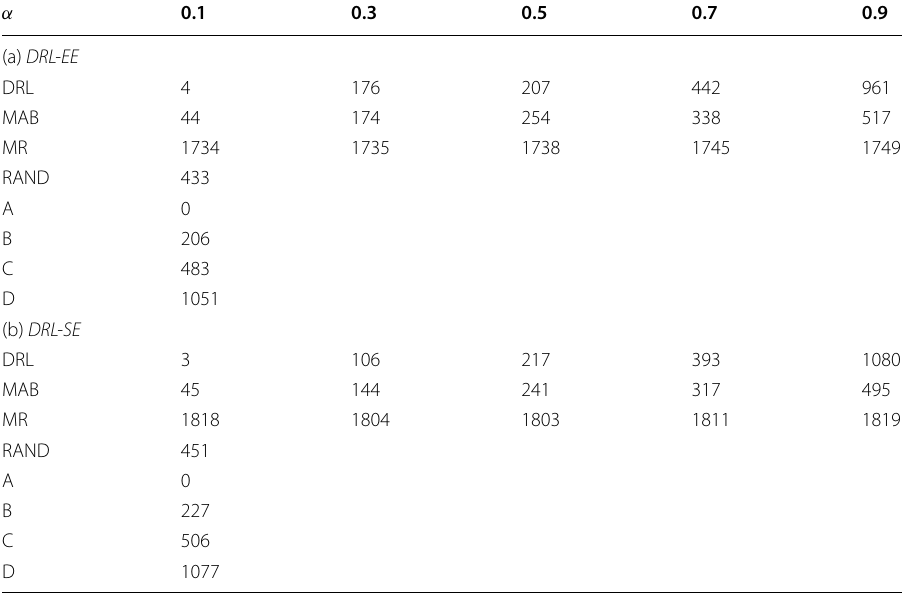
Table 5 The average number of beam measurements required for DRL-EE and DRL-SE, respectively, with different trade-off factors α α